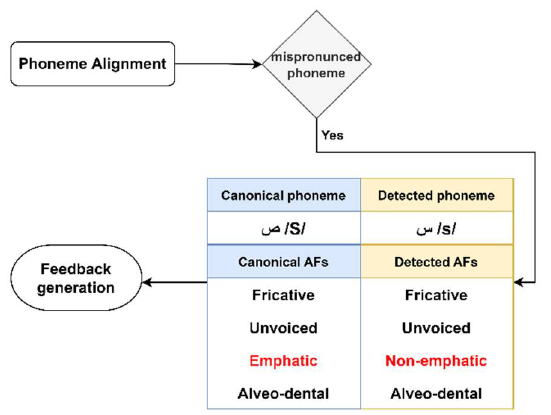
Figure 3. An example of feedback